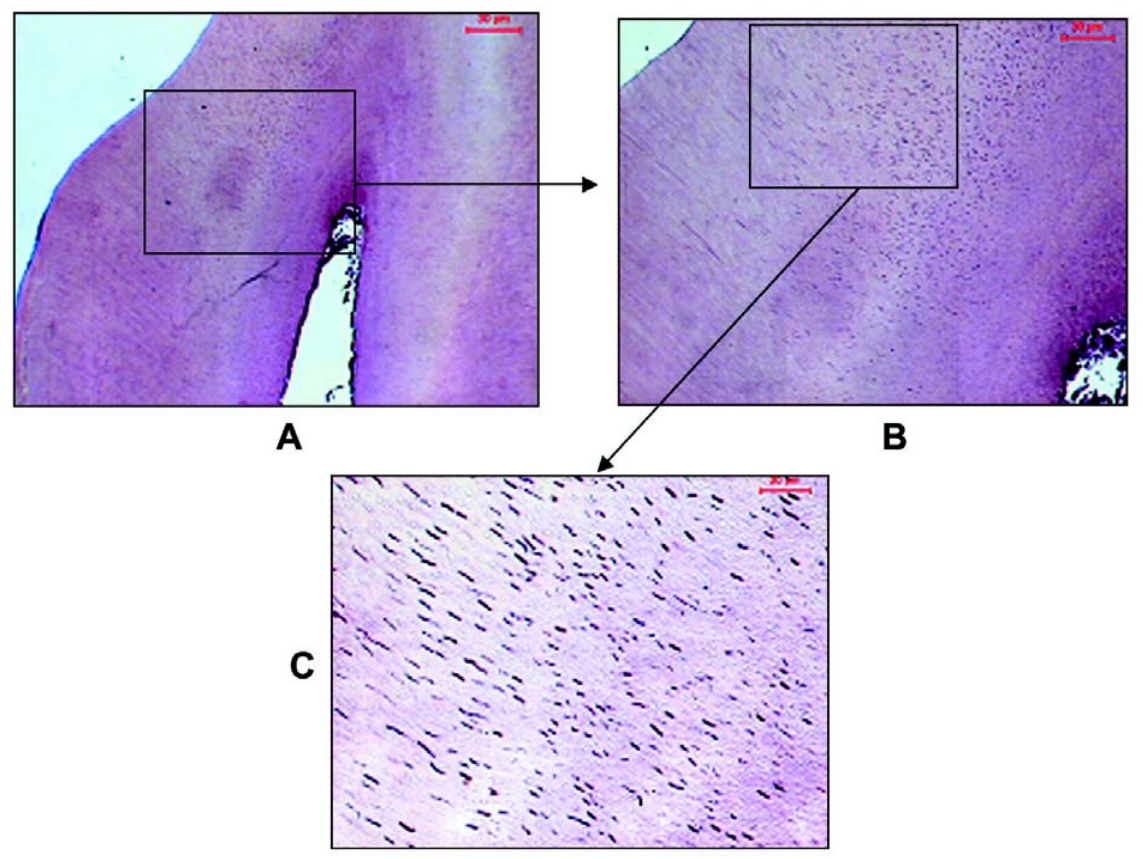
FIGURE 1- A – A survey view of the segments of the roots. B – The loss of cementum exposes dentinal tubules, allowing bacterial invasion of dentin. C – The bacteria are in depth in the dentin that is difficult to be eliminated by using periodontal mechanical therapy (original magnification, x4(A), x10(B),